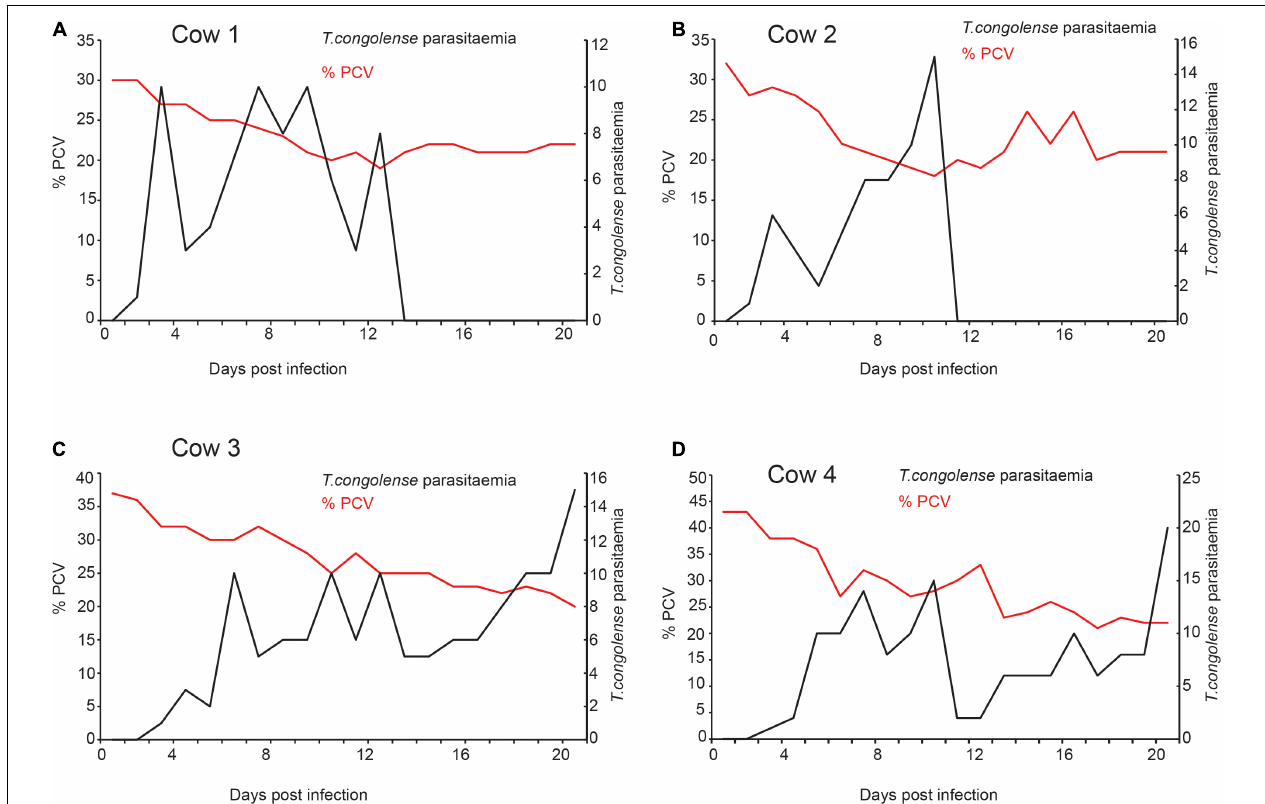
FIGURE 2 | Trypanosome infection caused anemia in infected cows (A–D) . The relation between T. congolense parasitemia and change in PCV. Right Y -axis black dotted graph is the change in parasitemia (number of trypanosomes/ml blood) from pre-infection (day 0) to 20 days post-infection. ( > 10 trypanosomes per field is equivalent to ∼ > 5 × 10 5 trypanosomes/ml blood; and 1–10 trypanosome per field is equivalent to ∼ 10 4 5 × 10 5 trypanosomes/ml blood). Left Y -axis the red-dotted line is the measure of Packed Cell Volume (PCV) recorded as a percentage of total blood volume, it measures the level of anemia from pre-infection (day 0) to 20 days post-infection. PCV < 25 considered